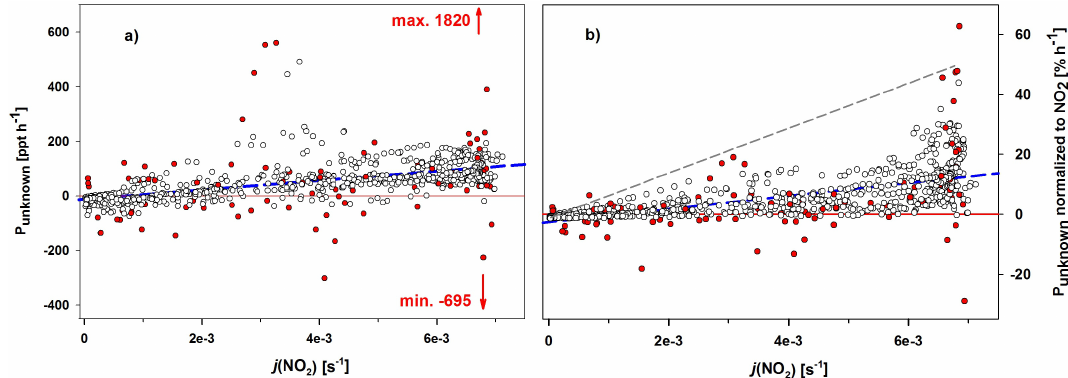
Fig. 4. (a) Unknown HONO daytime source ( P unknown ) in ppth − 1 for all days versus j (NO 2 ) . (b) P unknown normalized by NO 2 mixing ratios yielding a conversion frequency (%h − 1 ) . Panel (a) contains only data points ( N = 753) which could be normalized to NO 2 . Points where 1 HONO/ 1t was larger than the relative error of the LOPAP ( ± 12%) are marked as filled red points. Blue dashed lines are linear fits to the data with (a) r 2 = 0 . 16 and (b) r 2 = 0 . 38. The grey dashed line in Fig. 4a presents an upper limit based on the mean of the five lowest points at ( j NO 2 ) min and five highest points at ( j NO 2 ) max